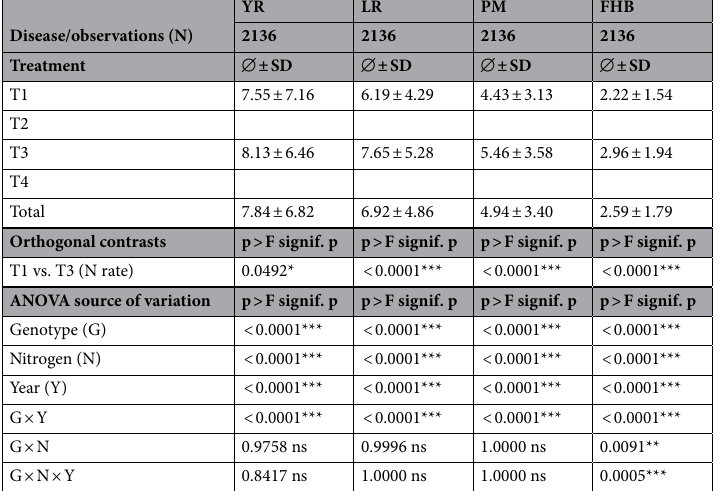
index (HI). While in general low in the drought stress years, HI was higher in T2 vs. T4 in 2015 (0.313 vs. 0.297) and 2017 (0.399 vs. 0.358). It was opposite in 2016 (T2: 0.378 vs. T4: 0.409). Higher N application was in general more successful with regard to crude protein (+ 10.4% in T4 vs. T2 over all three years, data not presented in the manuscript). Y also affected TKW, ESM, BM and HI of single genotypes as indicated by significant G × Y interac- tion, which was not the case for KPS and GRY. Genotype × plant protection (G × PP) interaction was significant for GRY, TKW, ESM, BM, and HI but not for KPS. G × N interaction was only significant for HI. The three-way G × PP × N rate interaction and the four way-interaction (G × PP × N × Y) were not significant for any trait. Impact of major diseases and genotypic resistance on yield and yield components. Results of correlation analyses between disease and yield traits at both N levels are summarized in Table 3 and Fig. 1. In general, factorial relation and correlation between parameters of diseases, grain yield and yield components were similar at both N levels. Factor PCA indicated that GRY, BM, HI and TKW formed a cluster at the first two principal components, which explain 39 to 44% (PC 1 at 110 and 220 kg N ha −1 ) and 23% or 22% (PC 2 at 110 and 220 kg N ha −1 ) of the phenotypic variance. Accordingly, GRY, KPS, BM, and HI correlate very strongly with each other at both N levels. In contrast, yield component ESM shows only a weak positive correlation to GRY, BM, and HI at both N levels but no correlation to KPS and a weak negative or no correlation to TKW. With regard to diseases significant positive correlations were observed between YR and FHB (110 kg N ha −1 r = 0.25, 220 kg N ha −1 r = 0.46) and between YR and PM (110 kg N ha −1 r = 0.42, 220 kg N ha −1 r = 0.22). Highly signifi- cant negative correlations were detected between YR and LR (110 kg N ha −1 r = − 0.40, 220 kg N ha −1 r = − 0.45) indicating strong competition between the two rust pathogens. Correlations between LR and the other diseases as well as between LR with GRY and the yield components were relatively weak or not significant, likely due to the abundance of YR. Pairwise significant negative correlation coefficients between all fungal diseases taken together (Fungal sum) and GRY at both N rates (110 kg N ha −1 r = − 0.67, 220 kg N ha −1 r = − 0.76) clearly dem- onstrate the impact of fungal diseases on yield. In other words, approx. 50% of the differences in grain yield can be explained by the additive or combined effect of the fungal pathogens. Likewise, the cluster of GRY and yield- related parameters had a factor load opposite to YR at both N levels and additionally opposite to PM at low N and FHB at high N (Fig. 1). In detail, highly significant negative correlations were observed primarily between